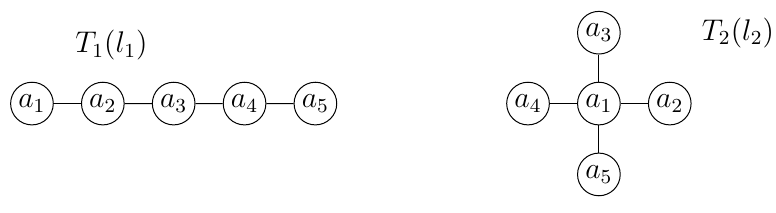
( l ) generate some isometric ultra- 2 2